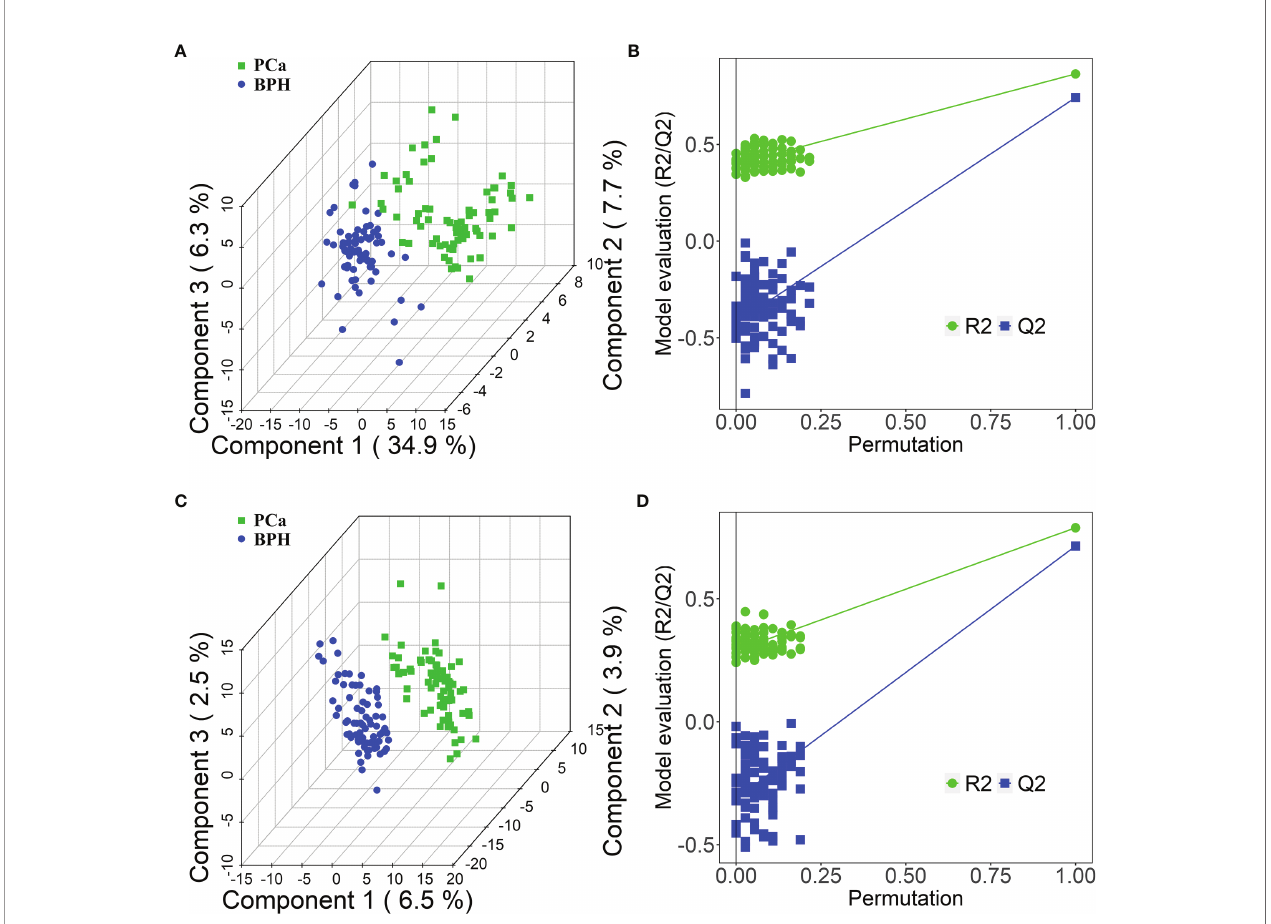
FIGURE 3 | PLS-DA score plots in positive (A) and negative (C) ion modes between PCa and BPH groups. PLS-DA permutation test plots in positive (B) and negative (D) ion modes between PCa and BPH groups. The criterion for evaluating whether there is over fi tting in the PLS-DA model is that the regression line at a blue Q2 point crosses or is less than 0 from the abscissa. PLS-DA, partial least squares discriminant analysis; PCa, prostate cancer; BPH, benign prostatic